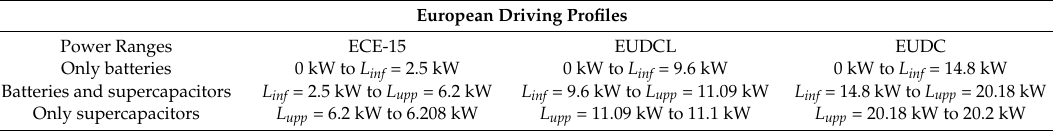
Figure 3. Normalized battery mass evolution depending on the maximum power delivered by the fuel cell for architecture 1B: ( a ) ECE-15 cycle. ( b ) EUDCL cycle. ( c ) EUDC cycle [28]. Table 2. Power range limits for the analyzed European driving profiles.